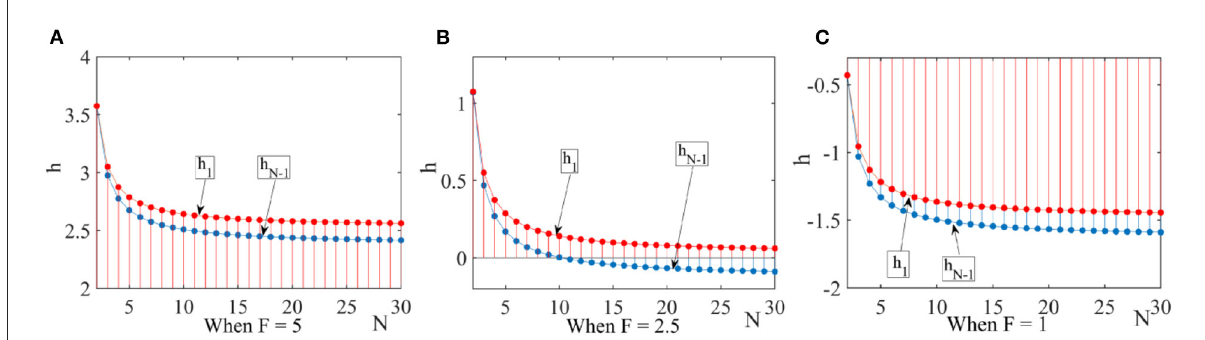
FIGURE4 Effect of the number of pharmaceutical enterprises on strategic choice. This figure shows that under the dominance of expected returns the effect of the number of pharmaceutical enterprises on the strategic choice when considering different government penalty. (A) When F = 5, (B) When F = 2.5, (C) When F = 1.